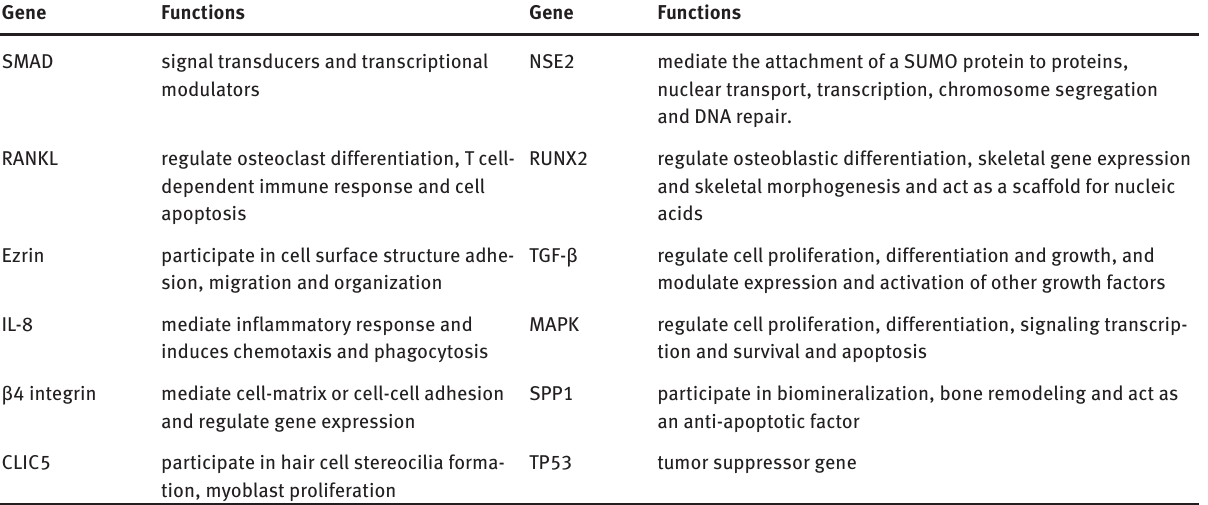
Table 4: Gene name, functions of 12 reference metastasis genes involved in Osteosarcoma [46]. Gene Functions